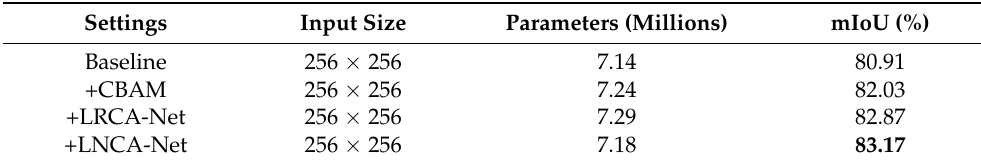
Table 3. Experiments on the ablation of attentional mechanisms using the same dataset (BDCI 2017), where bold numbers indicate the highest mIoU, “ + ” indicates that a particular attention module has been added to the baseline.